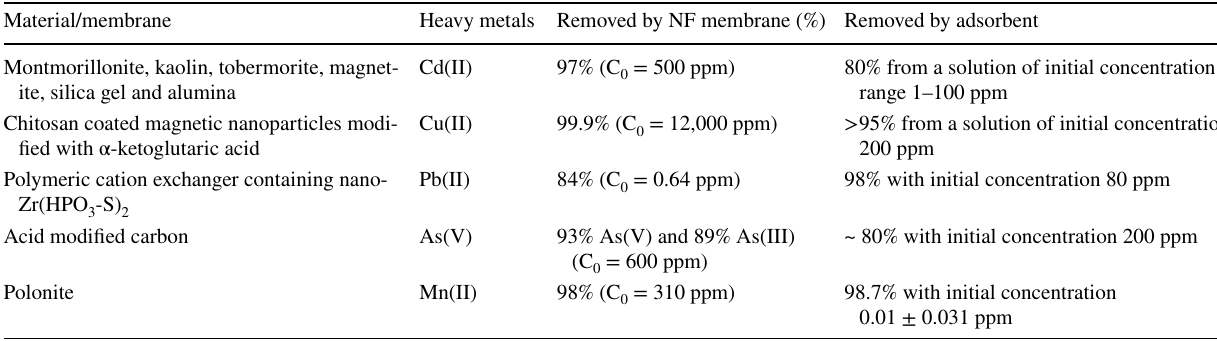
Table 2 Results (removal of heavy metals) obtained by NF (nanofiltration) and by adsorption